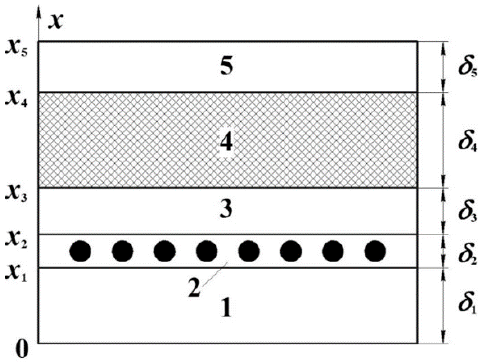
Figure 2. Thermodynamic system: 1 — lower layer of the thermal fixture, 2 — resistive layer with in- ternal heat sources, 3 — upper layer of the thermal fixture, 4 — moulded package of polymeric com- posite material, 5 — auxiliary layer.